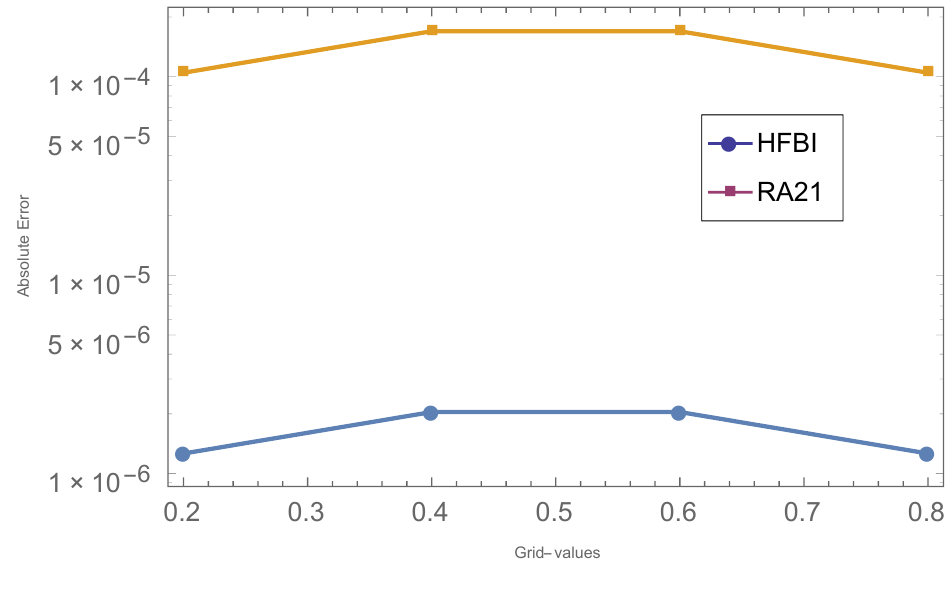
Figure 3. Efficiency curve for Problem 2. Table 4. Numerical results of exact-solution, computed-solution and the Absolute error of the HFBI for Problem 2.